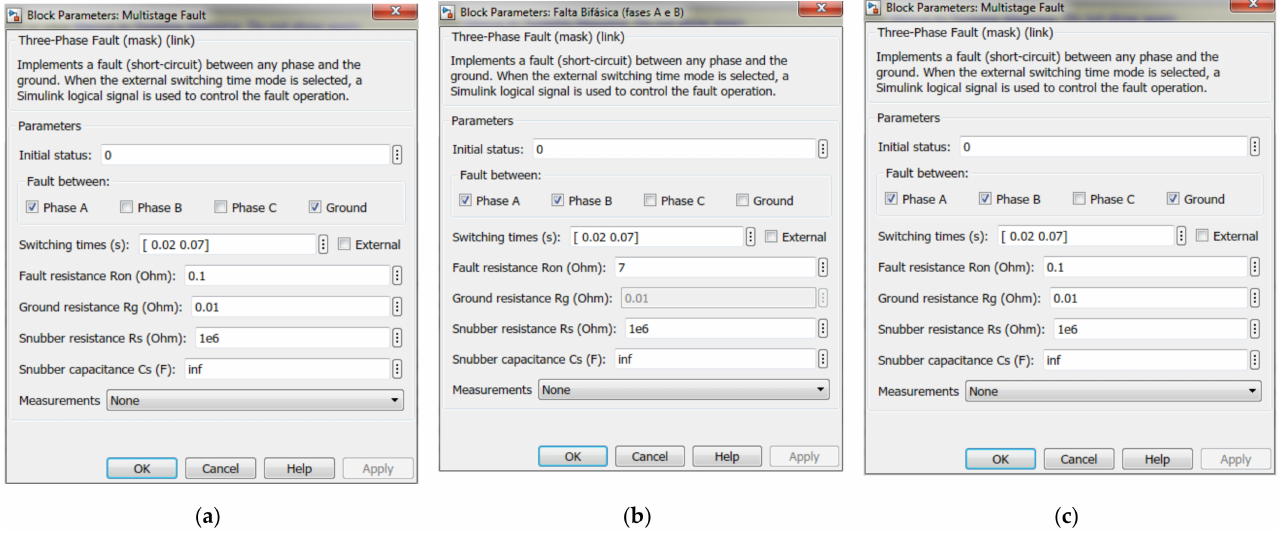
Figure 7. Fault types. ( a ) Phase-to-earth causes voltage sag, ( b ) phase-phase causes voltage swell and ( c ) phase-phase-to- earth causes interruption.